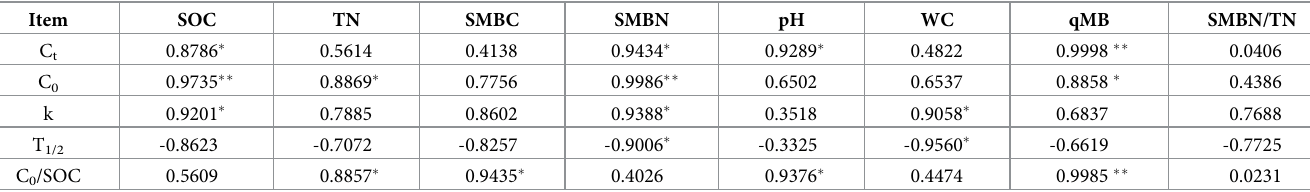
Table 3. Pearson correlation coefficients between mineralization parameters and basic soil